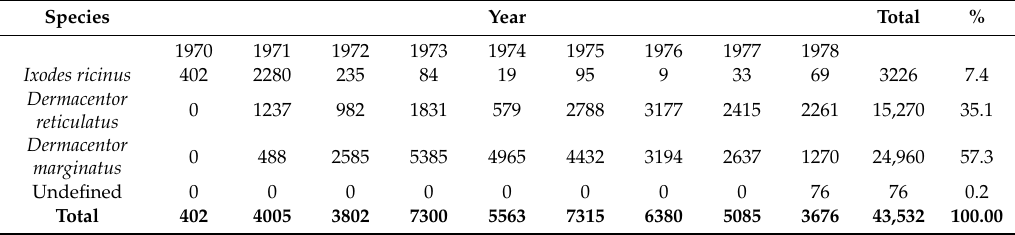
Table 4. Ixodid ticks collected by Borˇci´c and his group in the period from 1970 to 1978 in the region of Middle Posavina. Altogether, 43,532 ticks were collected in the region of Middle Posavina. The table below shows number of collected samples per species and per year, as well as total number. Ratio of collected single species is expressed as a percentage of total collected samples. F. tularensis was isolated only from one pool of D. reticulatus .